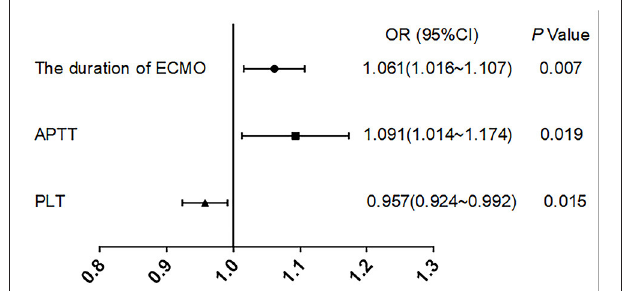
FIGURE 1 | Forest plot.